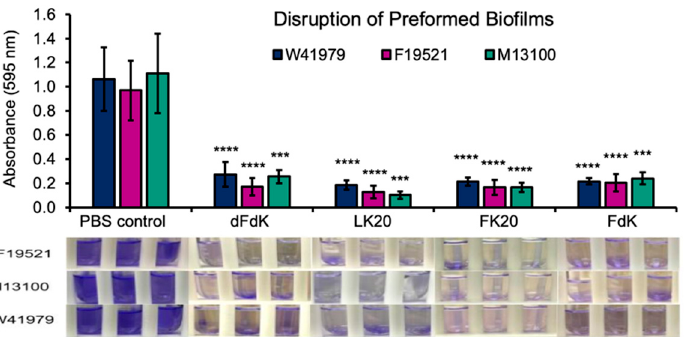
Figure 5. RPMs disrupt preformed A. baumannii biofilms. A. baumannii strains F19521, M13100, and W41979 were allowed to form biofilms statically in 10% lysogeny broth (LB) for 24 h before exposure to 100 µg mL − 1 random peptide mixtures (RPMs) or phosphate buffered saline (PBS) for another 24 h. The number of biofilms was determined by crystal violet staining. *** p < 0.001 and **** p < 0.0001 significance compared to respective controls as determined by the Student’s t